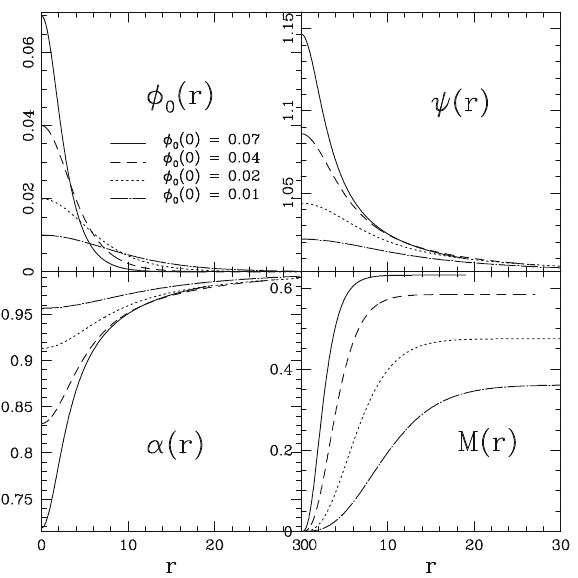
Fig. 2 Profiles characterizing static, spherically symmetric boson stars with a few different values of the central scalar field (top left). Reprinted with permission from Lai